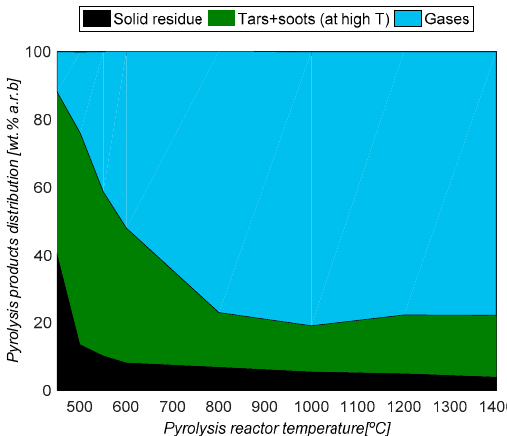
Figure 1. Pyrolysis product distribution (as received basis, a.r.b.) versus pyrolysis reactor temperature.